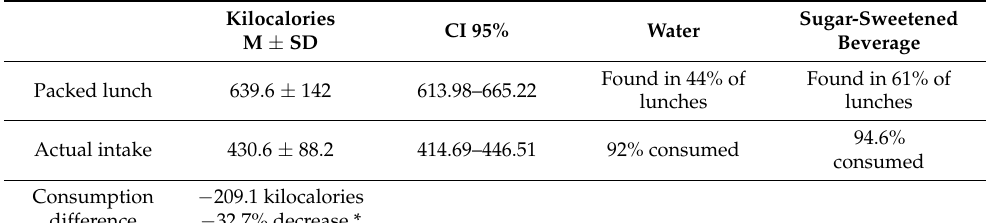
Table 1. Packed lunch content vs. actual energy and liquid intake ( n = 118).